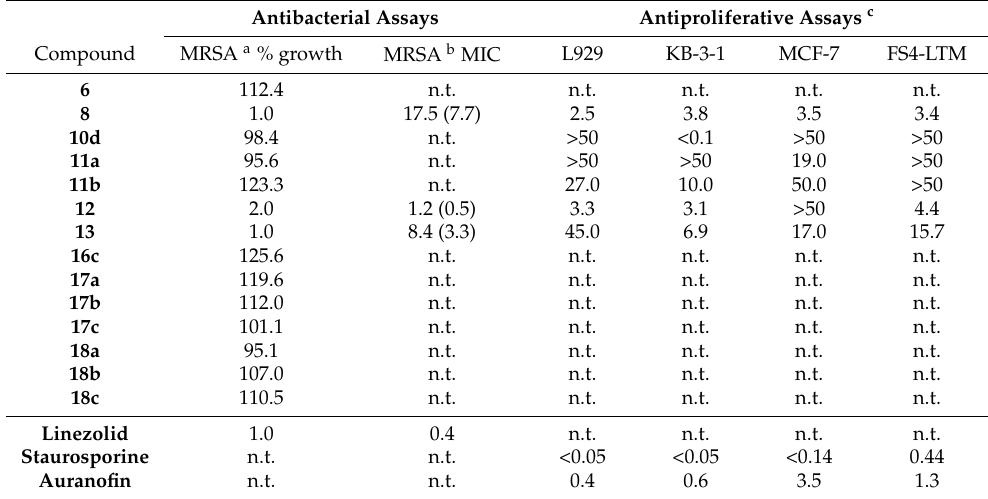
Table 1. Antibacterial and antiproliferative activities of selected benzo[ h ]quinolines. Antibacterial Assays Antiproliferative Assays c Compound MRSA a % growth MRSA b